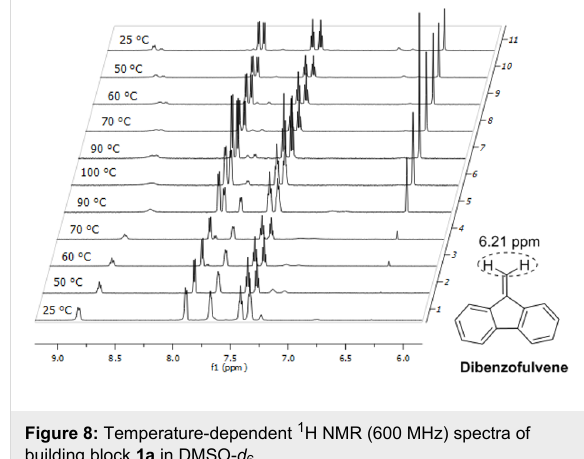
Figure 6: 1 H NMR (400 MHz) of PNA glycoconjugate 4 in CDCl 3 . The amide signals of the rotamers of 4 (2 doublets for each rotamer) are marked 1/2, 3/4, 5/6 and 7/8.